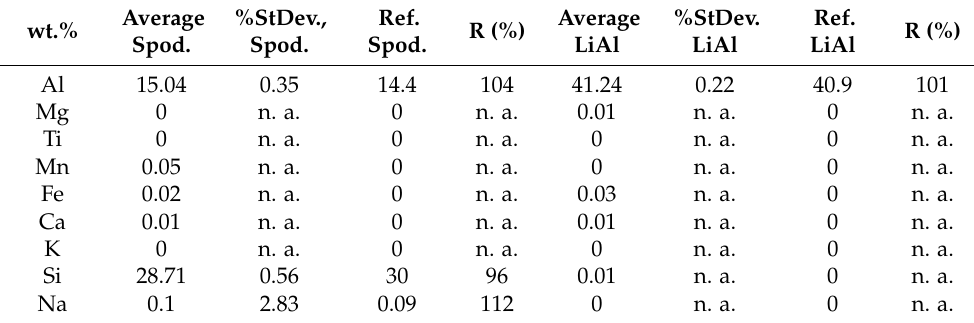
Table 1. Repeated measurements on two Li compounds. Spod, spodumene; %StdDev, percentage standard deviation of the measured points (repeats: n = 5); R, recovery; LiAl = LiAlO 2 . Average %StDev., wt.% Spod. Spod.